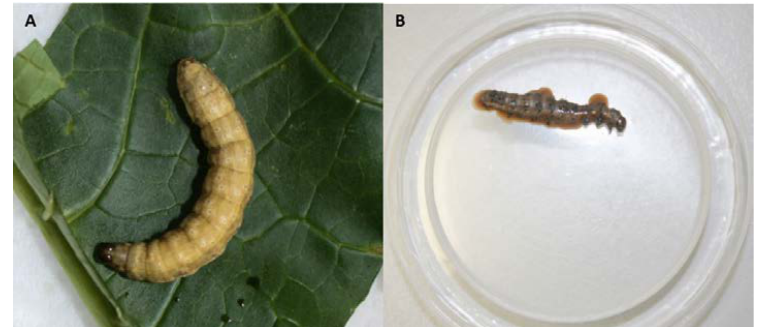
Table 1. Treatments evaluated in the greenhouse trial against S. frugiperda